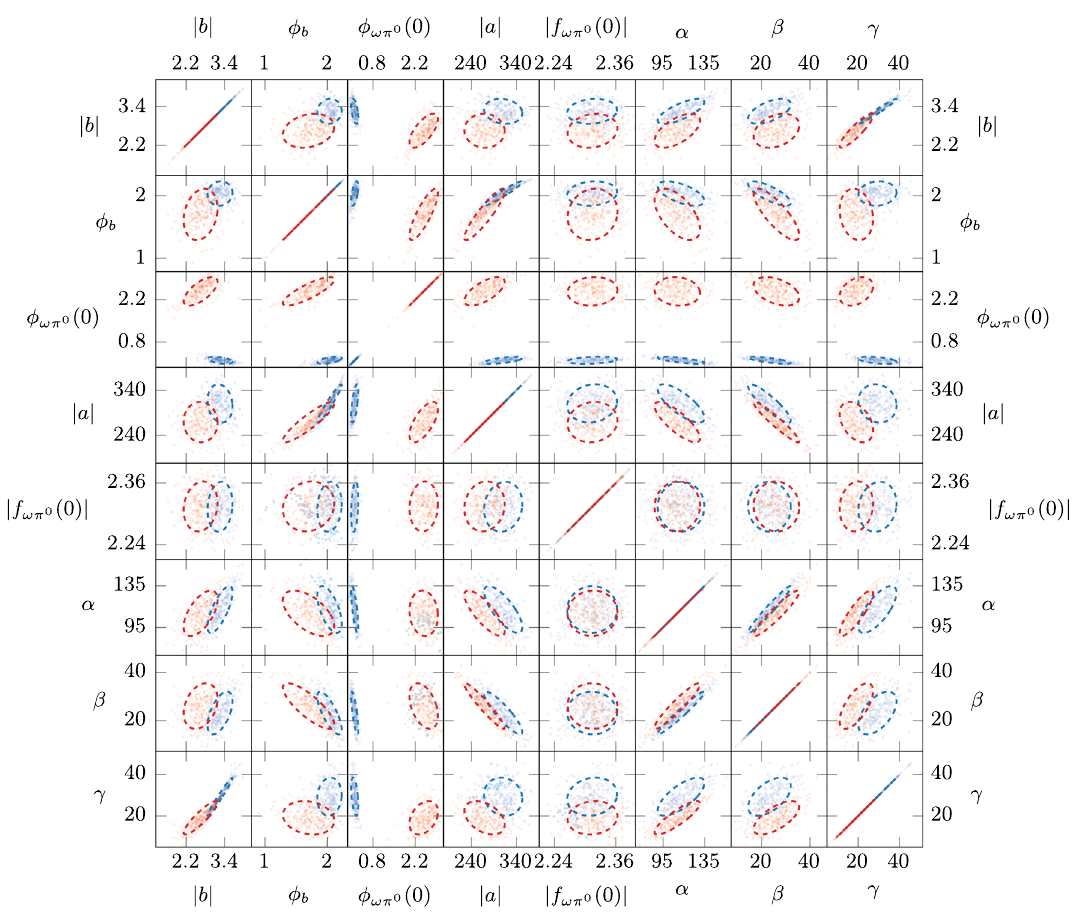
Fig. 14 Two dimensional projections of the MC simulations, for the fitted and Dalitz-plot parameters. The blue (red) small points repre- sent a pair of values obtained in a single MC simulation for the low (high) φ ωπ 0 ( 0 ) solution. The ellipses represent the two-parameter 1 σ